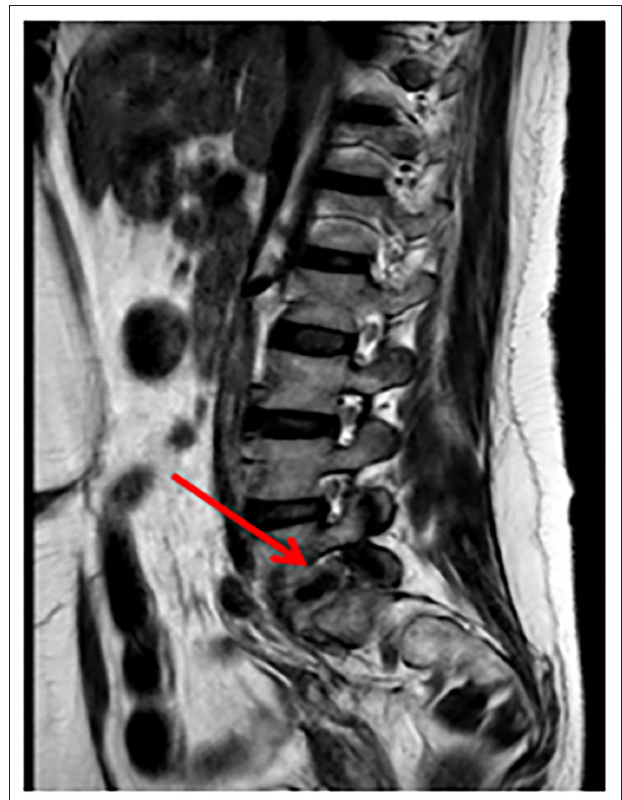
FIGURE 1 | Pelvic MRI: enhancement of soft tissues surrounding the L5-S1 vertebrae (arrow). MRI, magnetic resonance